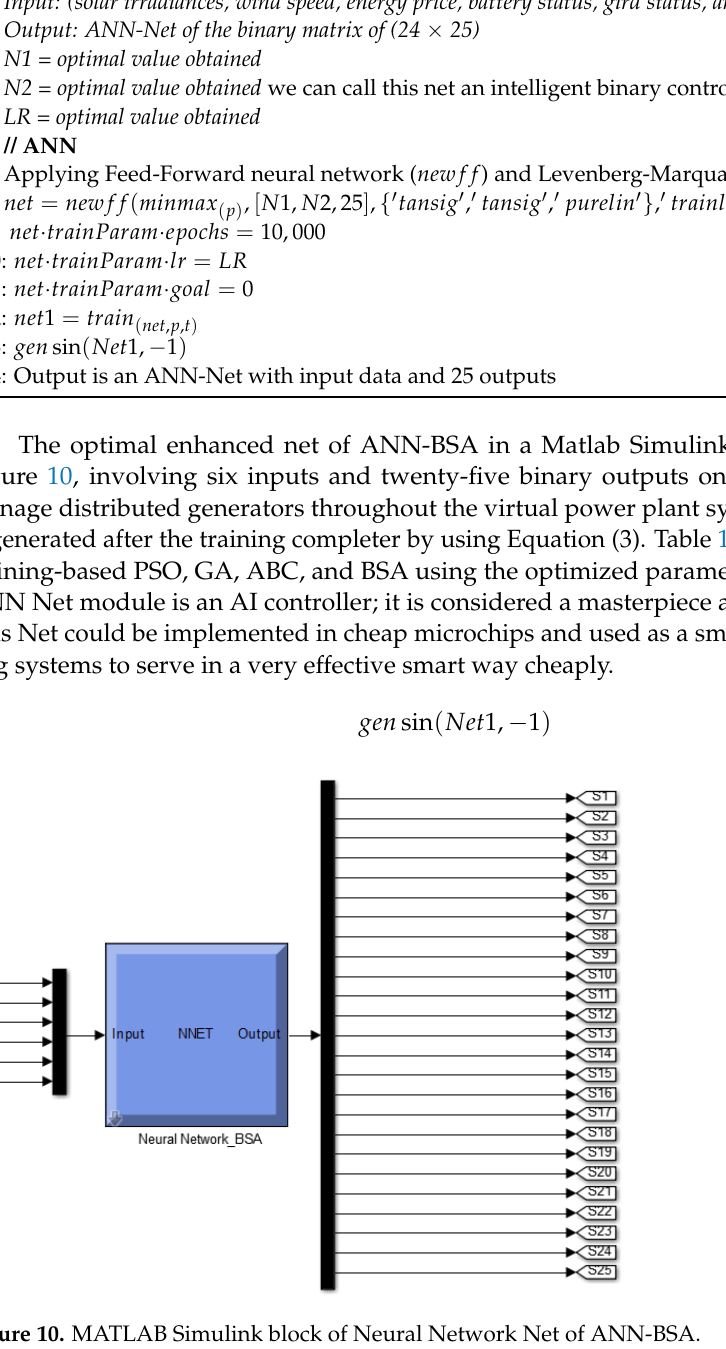
Figure 10. MATLAB Simulink block of Neural Network Net of ANN-BSA. Table 13. Artificial neural network training-based PSO, GA, ABC, and BSA using the optimized parameters obtained. Optimization Al-